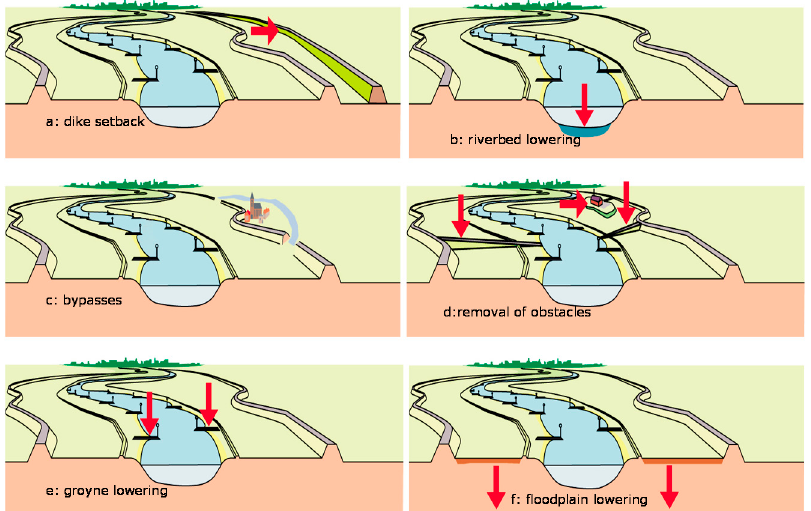
Figure 9. Measures of Room for the River. Top: dike setback to widen floodplains ( a ) and riverbed lowering ( b ). Centre: bypasses or secondary channels ( c ) and removal of obstacles or bottlenecks ( d ). Bottom: groyne lowering or replacement by longitudinal training walls ( e ) and floodplain lowering ( f ). (copyright RWS).